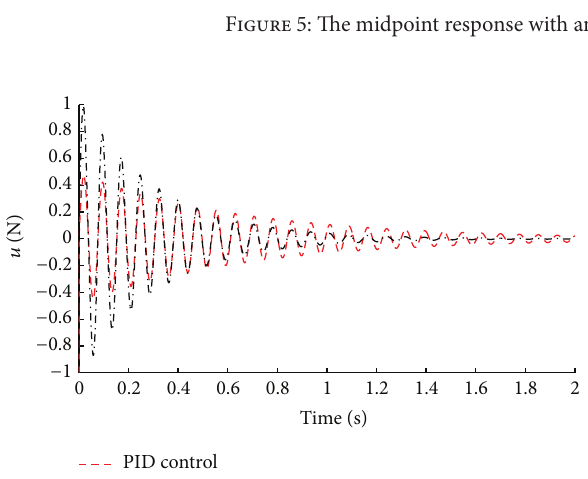
PID controller. The error norm is reduced markedly than traditional PID controller in the same time. Besides, the fuzzy self-tuning PID controller also has more adaptivity to different models in complex environments.